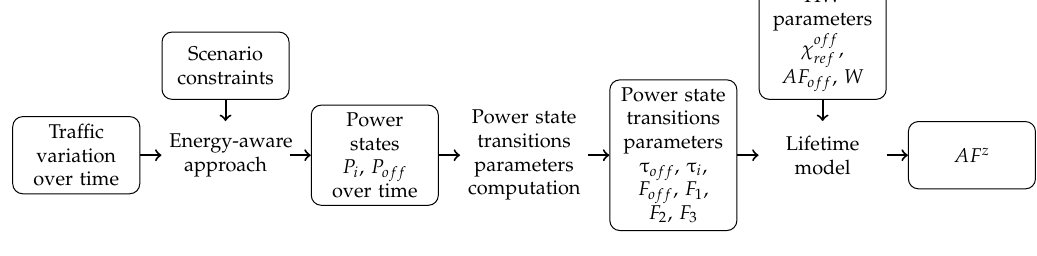
Figure 1. Main steps to compute the AF for the z -th base station (BS) in the